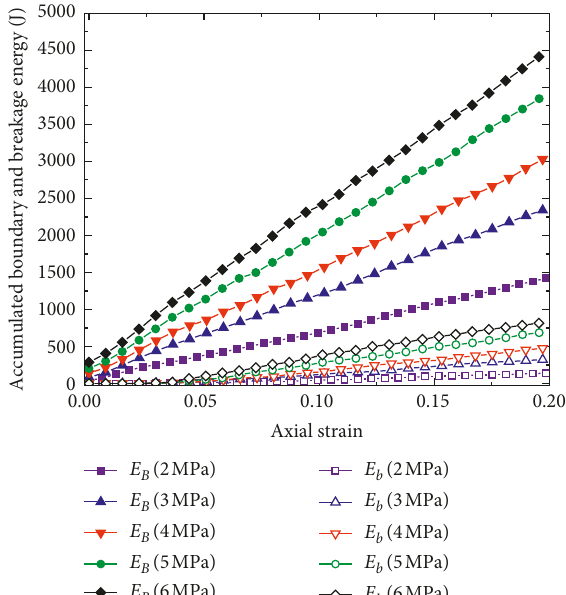
Figure 18: Evolution of input boundary energy and energy dissipated by breakage.